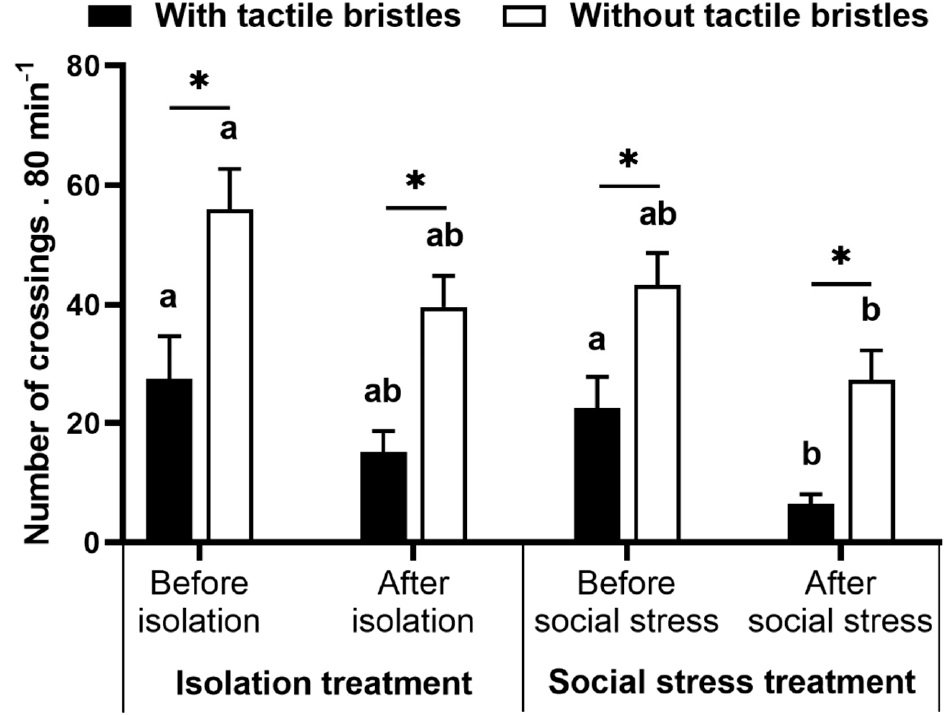
Figure 4. Preference test. Number of crossings through the area with or without tactile bristles over the periods before and after manipulation in isolation and social stress treatment. Data are mean ± SE. Mixed model ANOVA followed by SNK post hoc test. The asterisk indicates significant differences between areas with and without tactile bristles within treatments in the periods. Letters compare before and after manipulation for control and treatment groups. Similar letters indicate no significant differences.